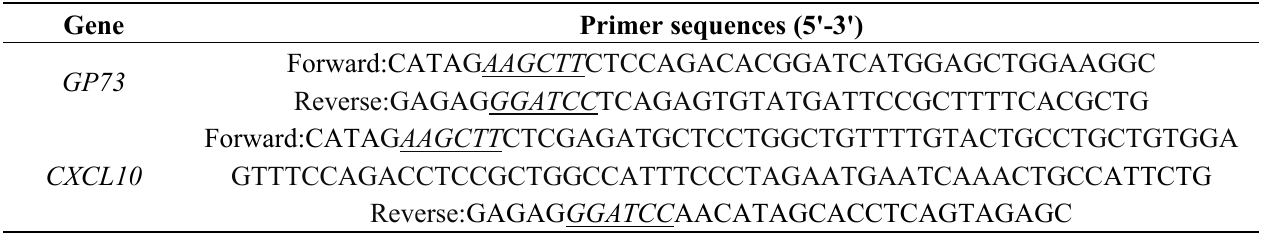
Table 1. Primer sequences for plasmids construction.